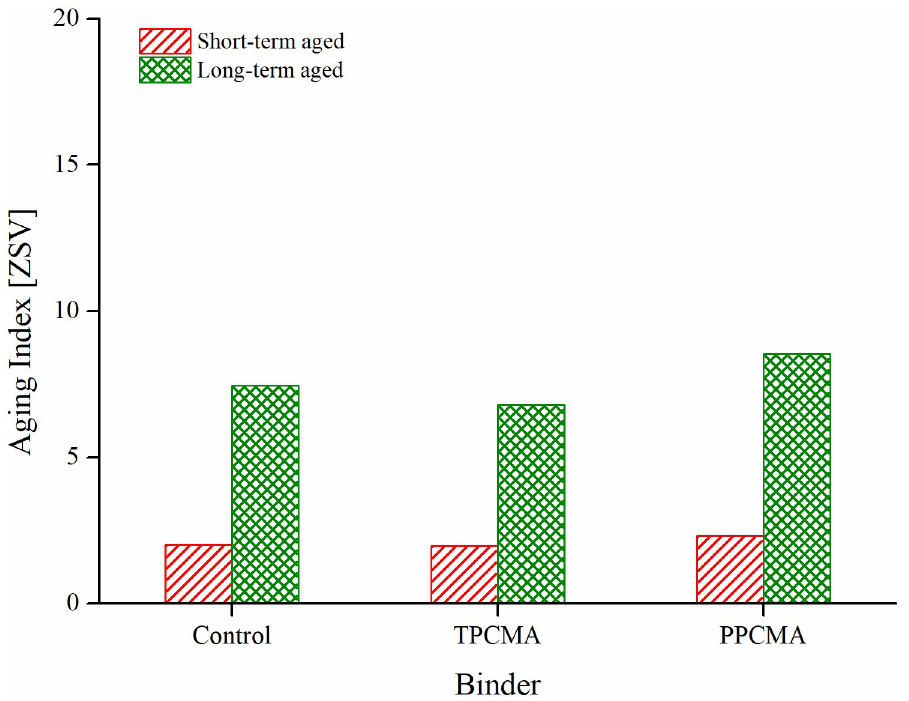
Fig 8. Aging index based on ZSV.